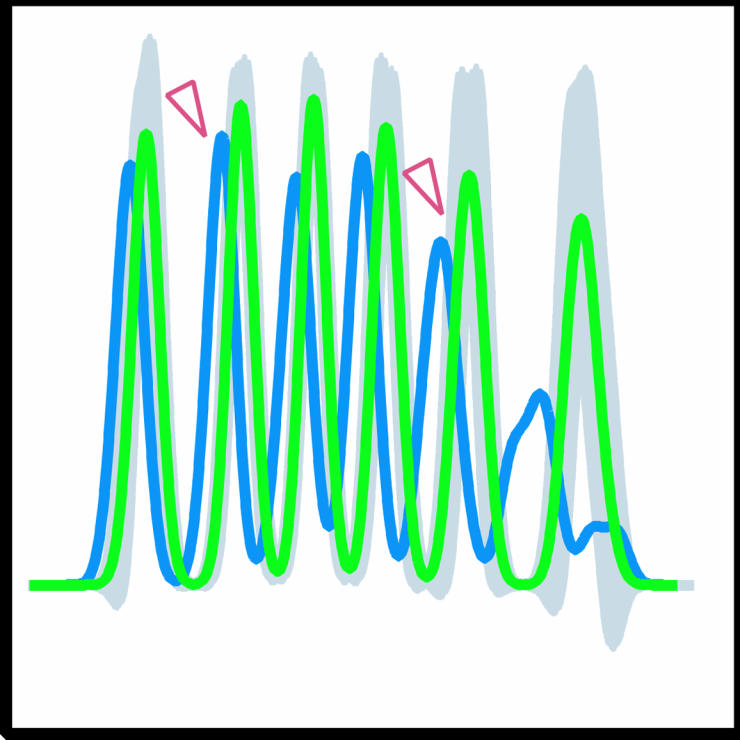
A mean peri-stimulus time histogram for two stimuli (blue and green) in the presence of a background oscillation. The gray shading represents the variance of the green stimulus; oscillations permit the discrimination of stimulus-specific situations (red arrows).